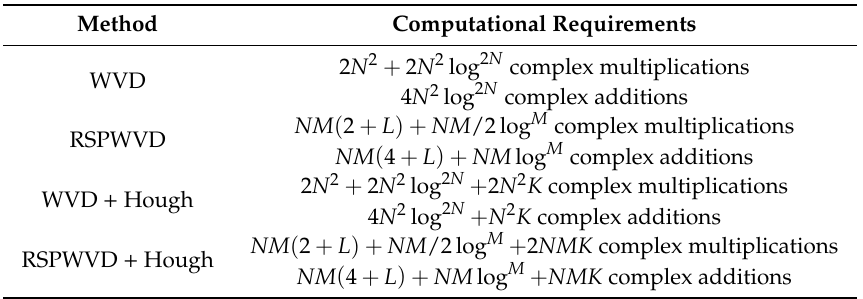
Table 3. Computational requirements of the Hough transform of WVD and